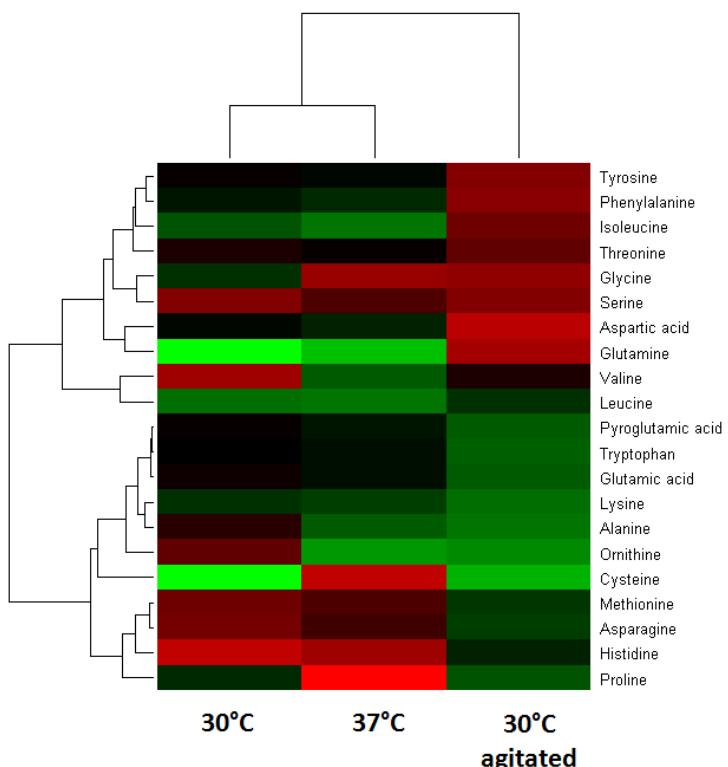
Figure 3. Double hierarchical clustering analysis of detected amino acids from non-agitated conditions of 30 °C and 37 °C, and 30 °C with agitation. Red color indicates relatively high abundance; green represents a relatively low